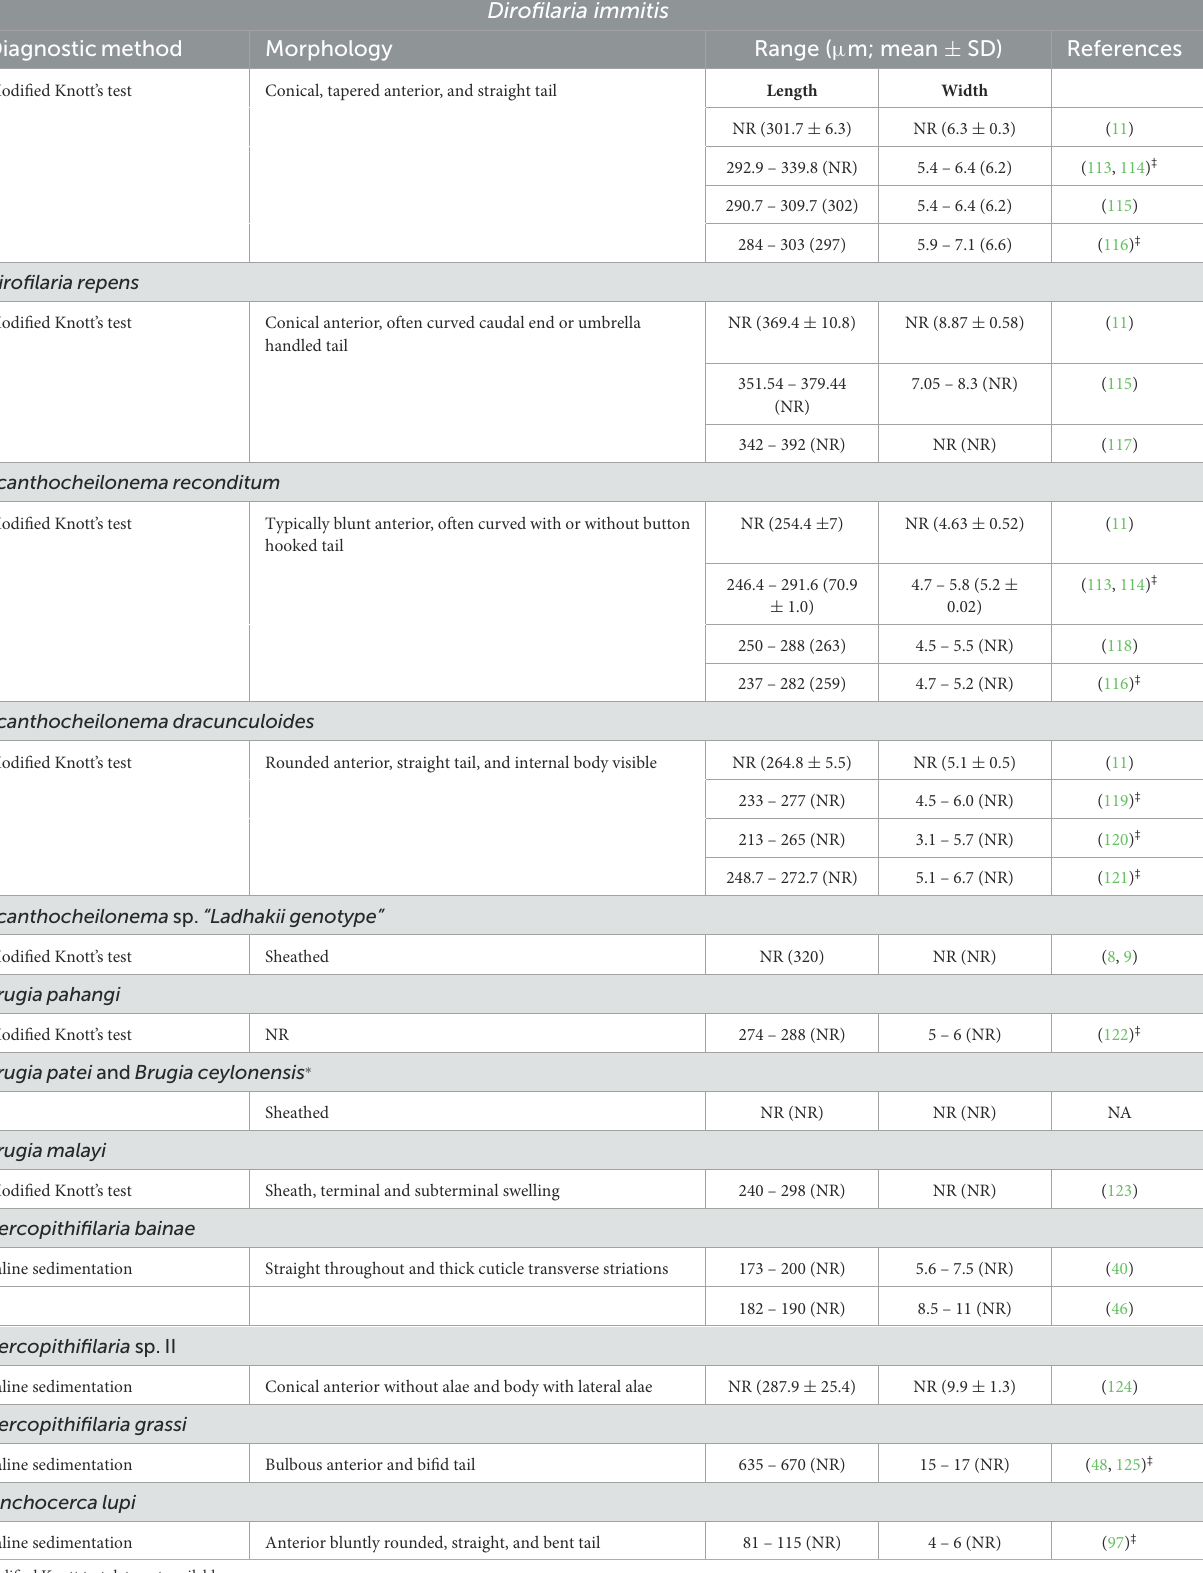
TABLE 2 Morphological and morphometrical data of microfilariae present in the blood and skin of